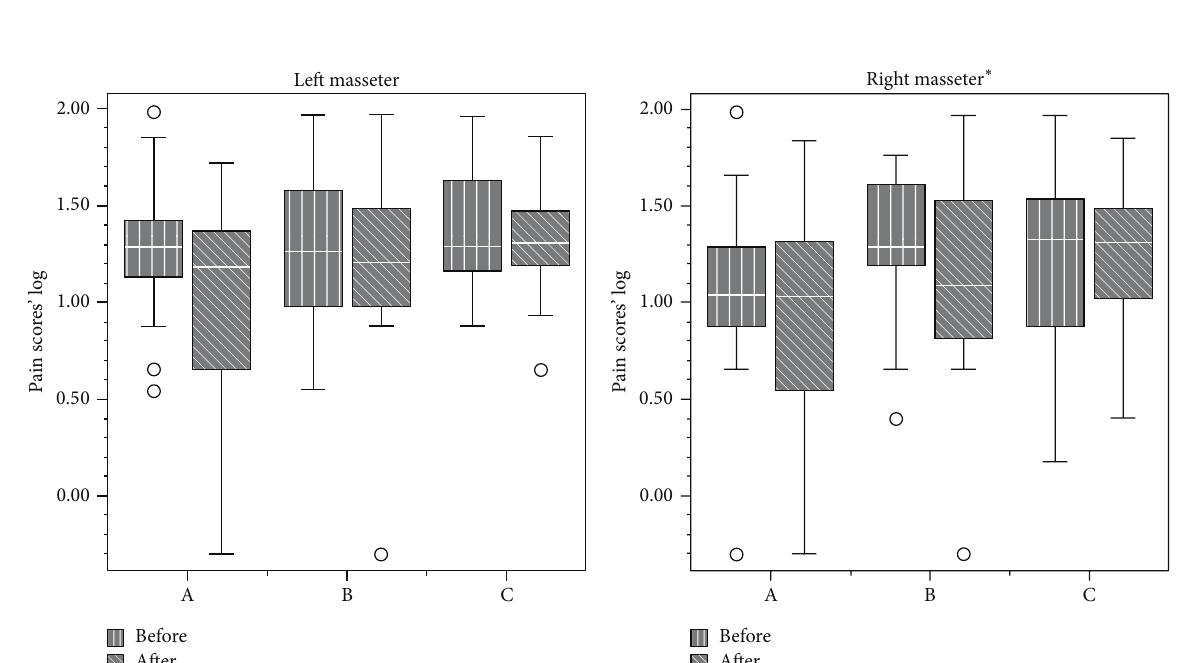
Figure 1: Pain scores (median and interquartile intervals) before and after treatment in the masseter muscle from groups A (NSAID—sodium diclofenac),B(panacea—sodiumdiclofenac+carisoprodol+acetaminophen+caffeine),andC(placebo).( ∗ Significantdifferences; 𝑃 < 0.05 ).